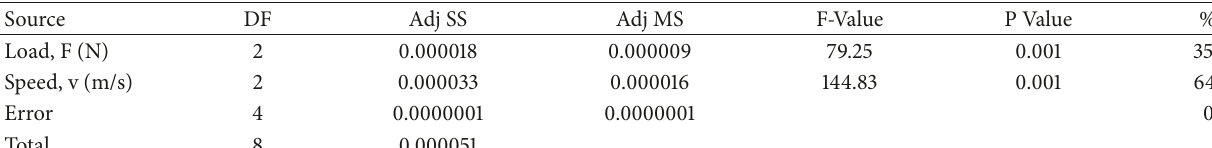
Table 5: ANOVA for volume loss of Zr-4.